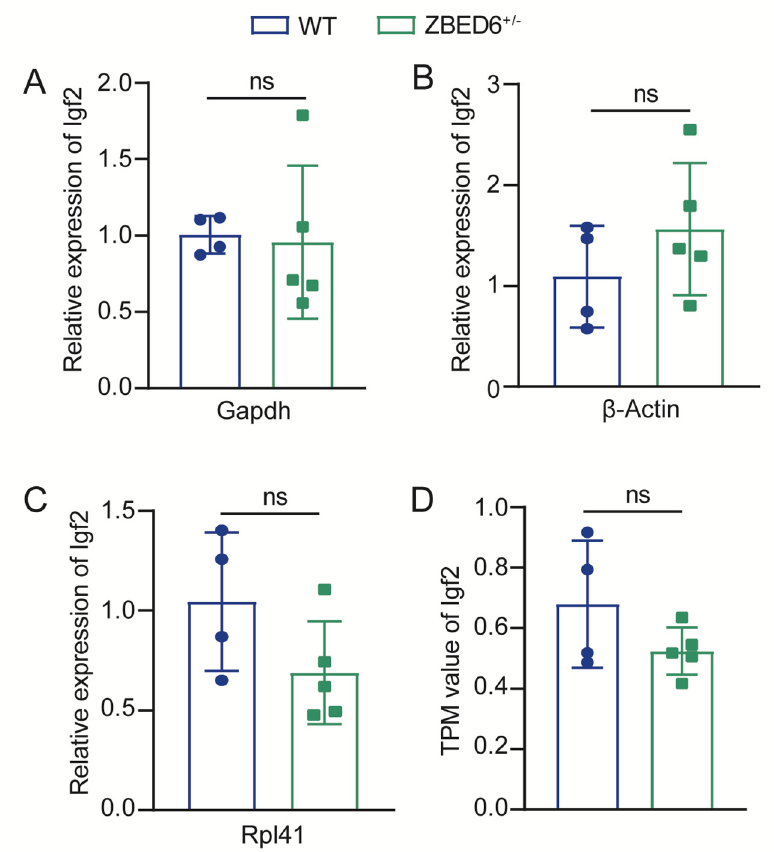
Figure 3. Igf2 level shows no significant change between WT (n = 4) and Zbed6 +/ − (n = 5) mice skeletal muscle. ( A – C ) qRT-PCR results of Igf2 mRNA expression in mice skeletal muscle from WT